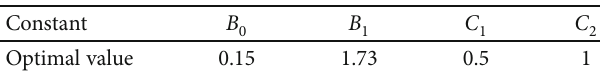
Figure 1: Schematic diagram of the liquid core. Table 1: Optimal KH-RT breakup model constants from Yang ’ s